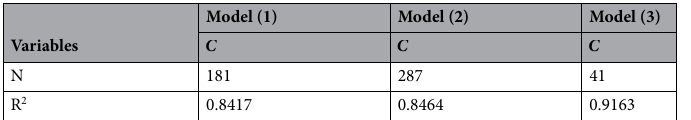
Table 4. Comparison of the results of our proposed method with those of Shan et al. 15 , Cai et al. 13 , and Jing et al. 14 . (1) The regression model is: C = α + β X + µ , where C represents the CO 2 emissions of this study, µ is the residual term, and X represents the CO 2 emissions of Shan et al. 15 , Cai et al. 13 , and Jing et al. 14 , respectively. (2) Models (1), (2), and (3) represent the results compared with the data proposed by Shan et al. 15 , Cai et al. 13 , and Jing et al. 14 , respectively. (3) We focused on the similarity of CO 2 emissions of this study with the other studies indicated here; thus, we have only provided the R 2 value. (4) N is the number of